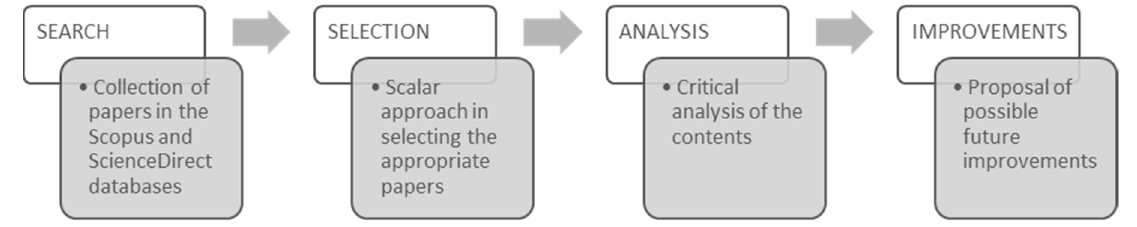
Figure 3. Methodological steps used to develop the proposed review work.